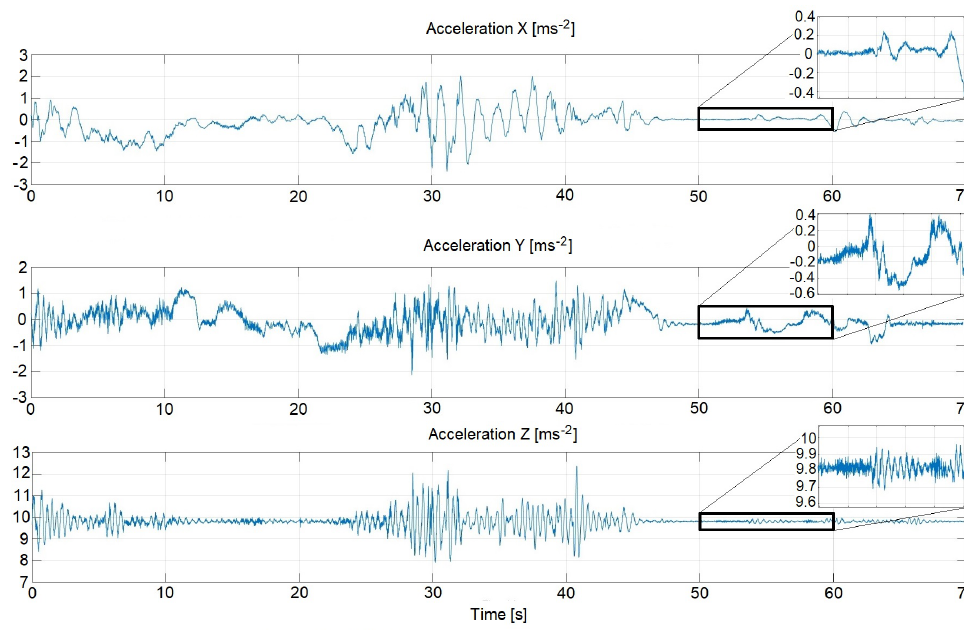
Figure 6. An exemplary data set [Source: MovieBird Intl.]. Table 2. Measured sensor noise variances—driving a car at a speed of 10